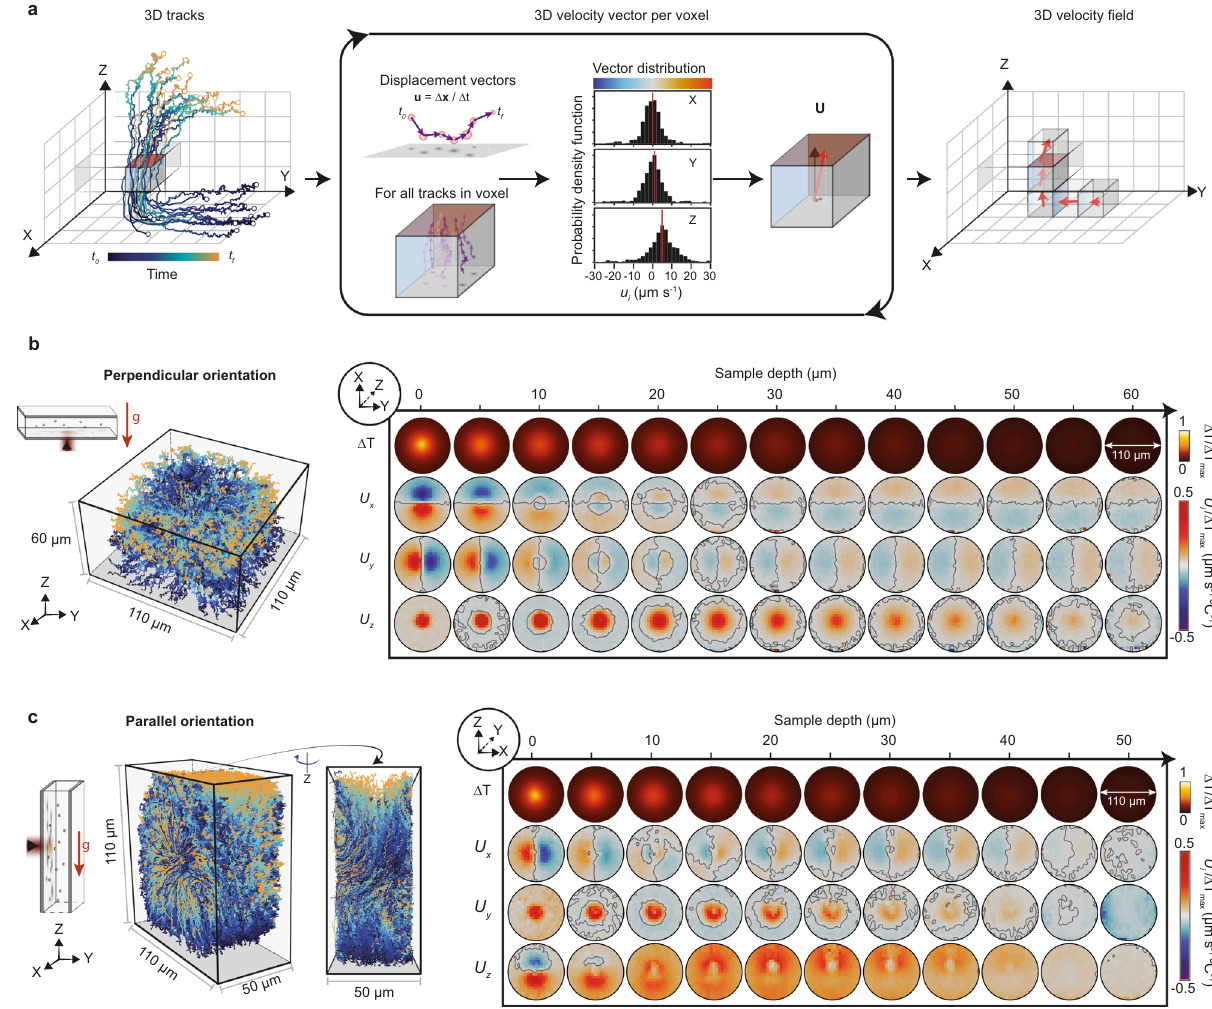
Fig. 3 Full 3D vector fl ow characterization and in fl uence of sample orientation. a Work fl ow to determine the 3D velocity fi eld over the imaging volume from the measured tracer particle trajectories. First, the instantaneous velocity vectors, u , are extracted for every track. Next, the imaging volume is divided into voxels and all instantaneous velocity vectors within a given voxel are collected for subsequent analysis. Then, from the instantaneous velocity vector distribution of said voxel, an ensemble average fl ow velocity vector, U , is determined. This process suppresses the Brownian motion contribution of each tracer particle in U . Finally, this procedure is repeated for all the remaining voxels. b Representative 3D particle trajectories, with time evolution encoded in color, together with the resulting 3D velocity fi eld map for an opto fl uidic platform with a nominal channel height of 50 µ m oriented perpendicular to the direction of gravity as shown in the schematic diagram. c Same as ( b ) but for an opto fl uidic platform that is oriented parallel to the direction of gravity. The scheme indicates the plane along which the maps in ( b ) and ( c ) are calculated given the change in orientation of the optical axis, XY and XZ respectively. Each row and column in the velocity maps correspond to a different vector component and channel depth position, respectively. Color encodes the direction and magnitude of the fl ow velocity, whereas the solid lines represent a contour line indicating a change in direction. All velocity vector components share the same magnitude scale, which has been normalized by the maximum temperature increase in the